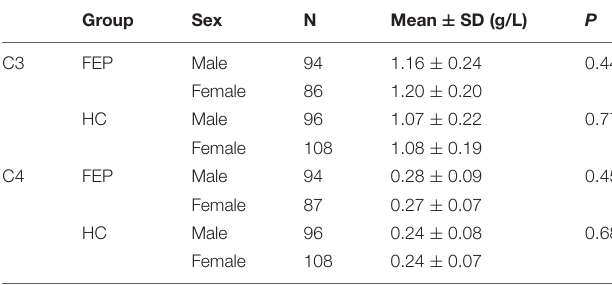
TABLE 4 | Subgroups of serum C3 and C4 levels according to sex and clinical